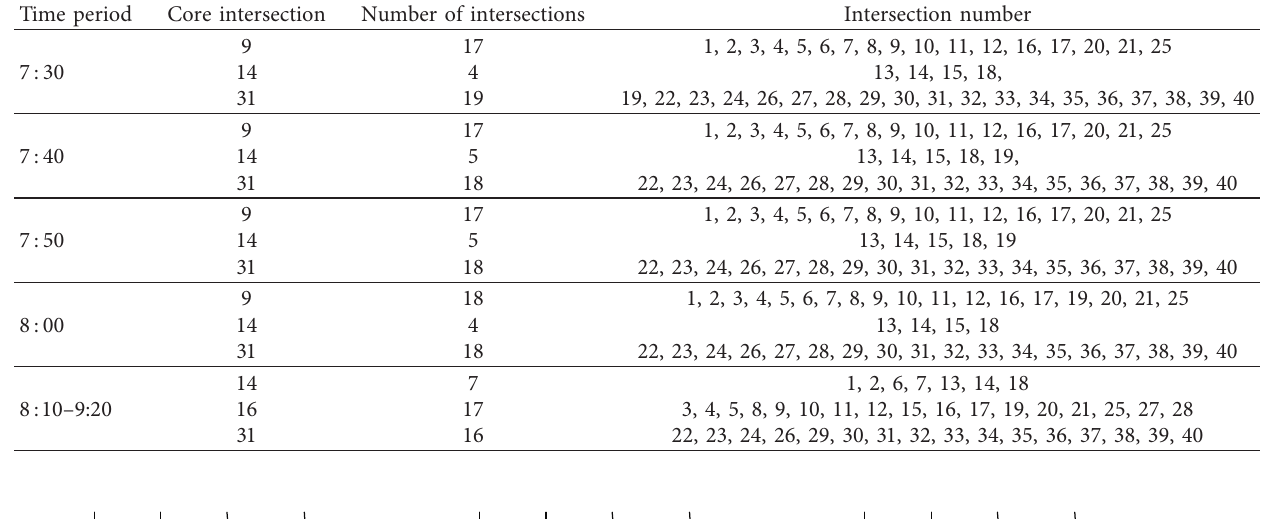
Table 4: Partition results of the second subzone.